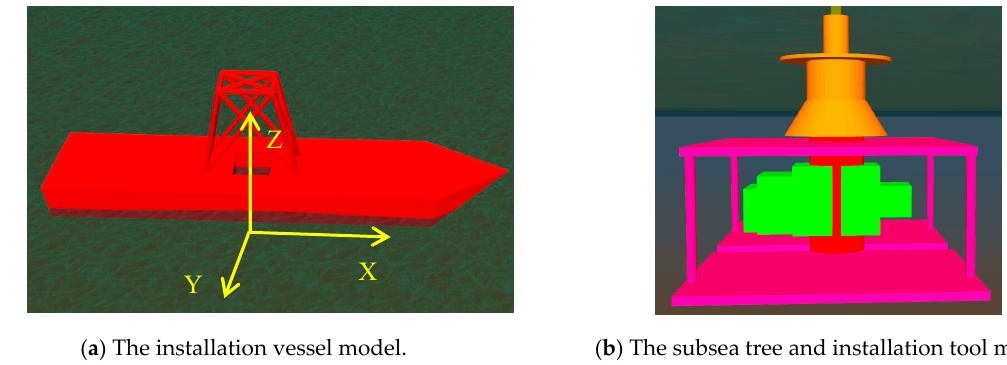
Figure 5. The installation vessel, the subsea tree, and installation tool 3D model. Table 3. Engineering ship parameters.